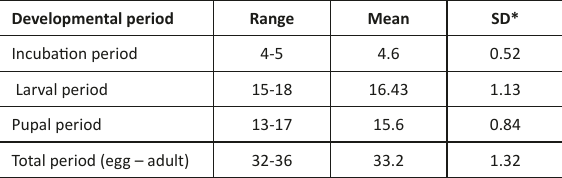
Table 2. Developmental period of different stages in Chilasa